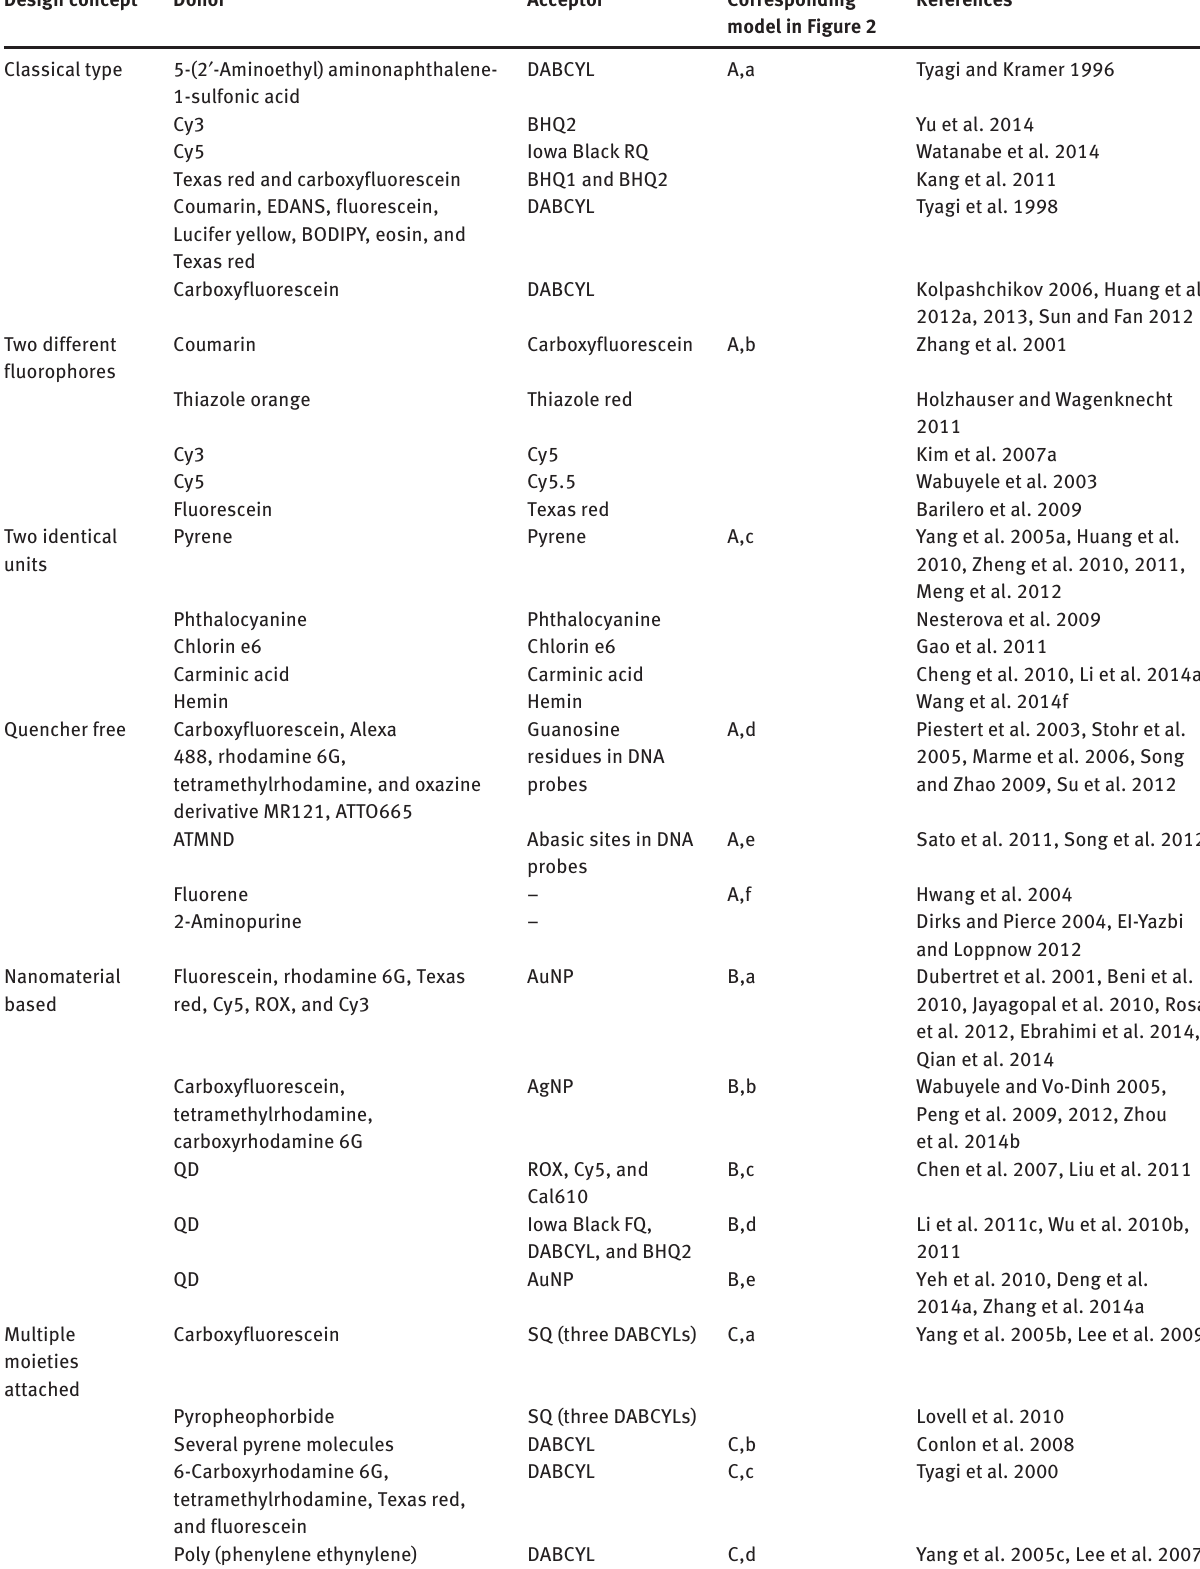
Table 1: MBs labeled with different signaling pairs. Design